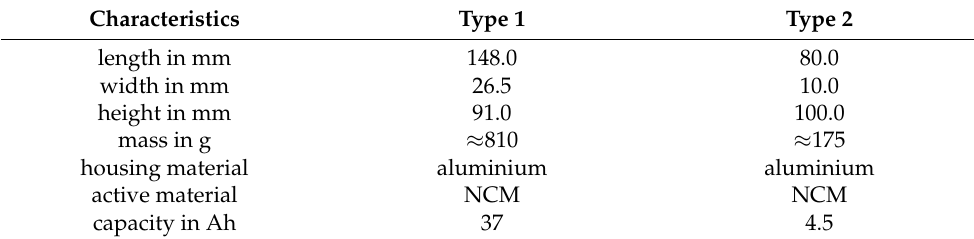
Figure 1. Battery cell type 1 ( left ) und type 2 ( right ). Table 1. Types of lithium-ion battery cells studied.